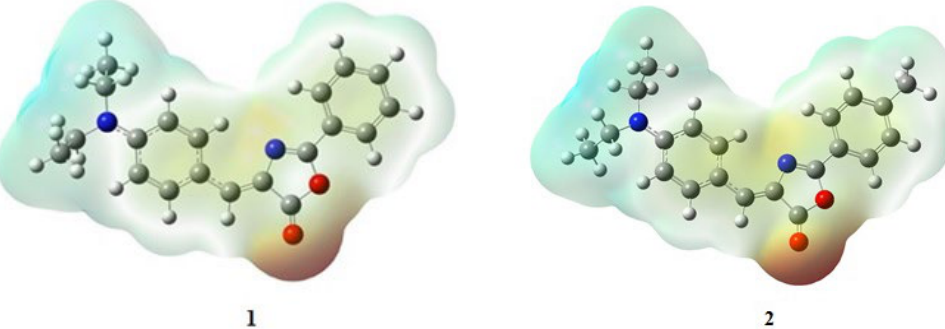
Figure 5. Molecular electrostatic potential surface (MEP) of the compounds 1 and 2